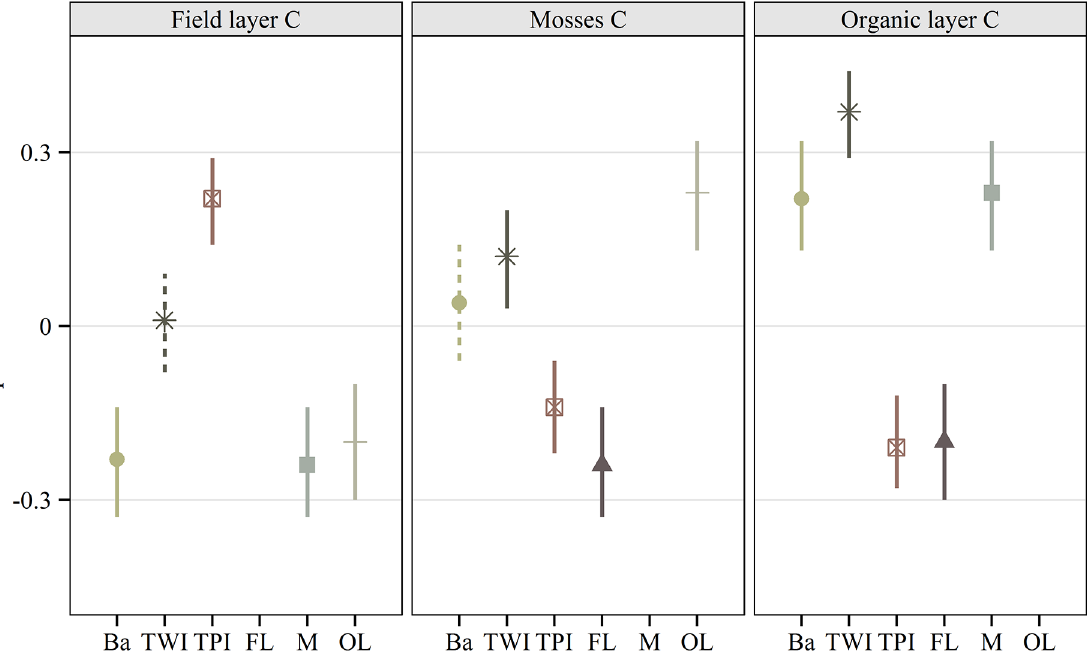
Fig 5. Overall correlation between individual sample characteristics. Spearman rank correlation (two-tailed) between C compartments and attributes of individual sampling point. Full lines indicate significant correlations (p < 0.01), while dotted lines show non-significant correlation (p > 0.01). Basal area (Ba) is computed in a radius of 5 m around each of the sampling points (n = 379). Topographic position index (TPI) and topographic wetness index (TWI) are derived from an interpolation of lidar ground echoes on 1 m 2 grid cells (both n = 577). The figure also shows correlation between individual C compartments, where FL = Field layer C (n = 580), M = Mosses C (n = 583) and OL = Organic layer C (n = 556). Correlations coefficients are displayed with 95% CI determined by bootstrapping 1000 random trials for each